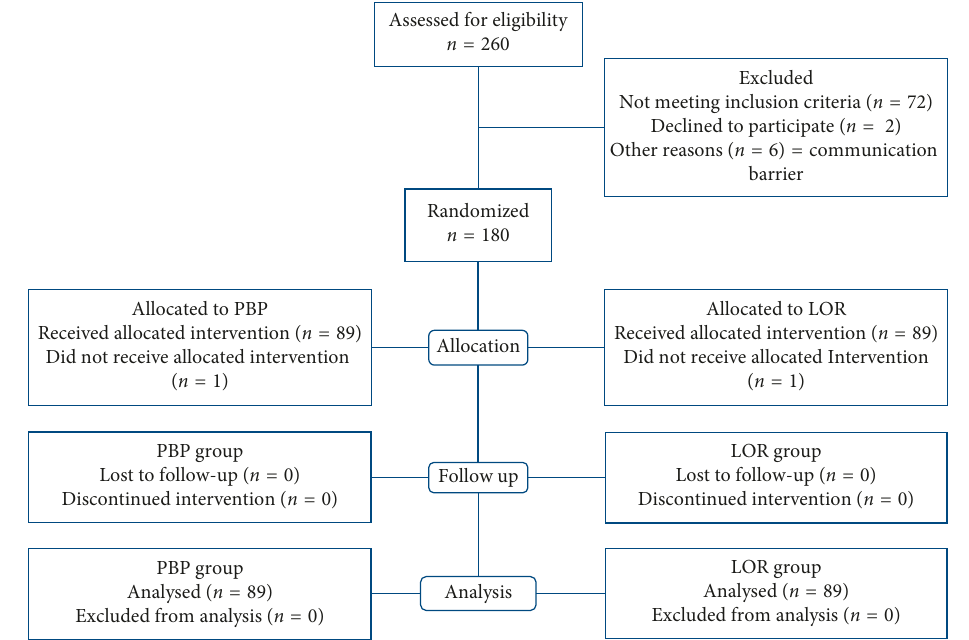
Figure 1: A CONSORT flow diagram of study patients. LOR � loss of resistance syringe method; PBP � pilot balloon palpation